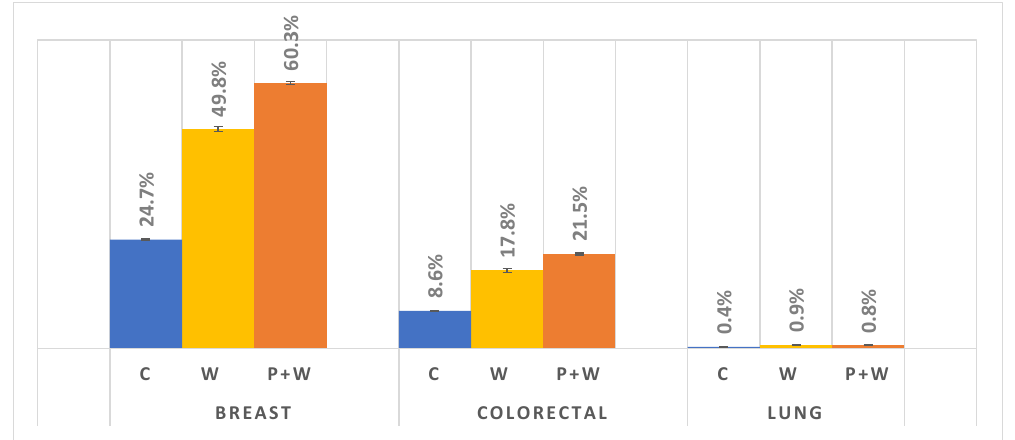
Figure 5. Cancer screenings participation during 1-year follow-up .